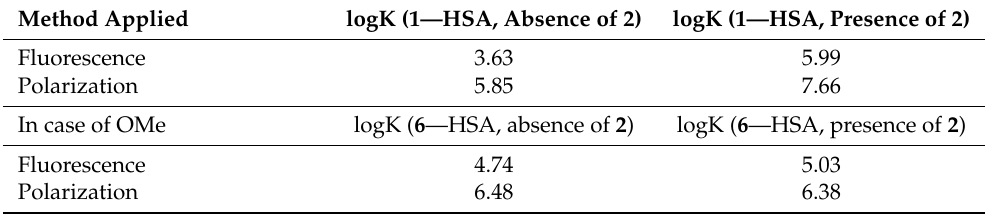
Figure 6. The Benesi–Hildebrand plots to determine the complex stabilities of nitroxide 1 and com- pound 6 with HSA in the absence (blue and red) and in the presence (purple and black) of cavitand 2 . Table 1. The determined stability constants of nitroxide 1 —HSA and 6 —HSA complexes (assuming 1:1 complexes) derived from fluorescence intensity or degree of polarization